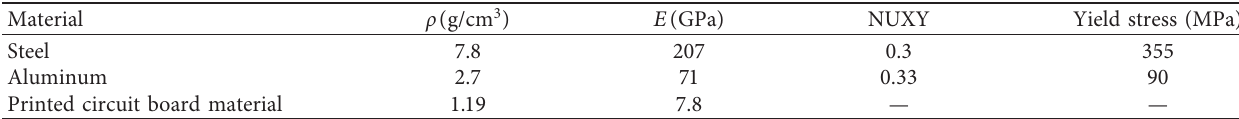
Table 4: Material parameters for simulation